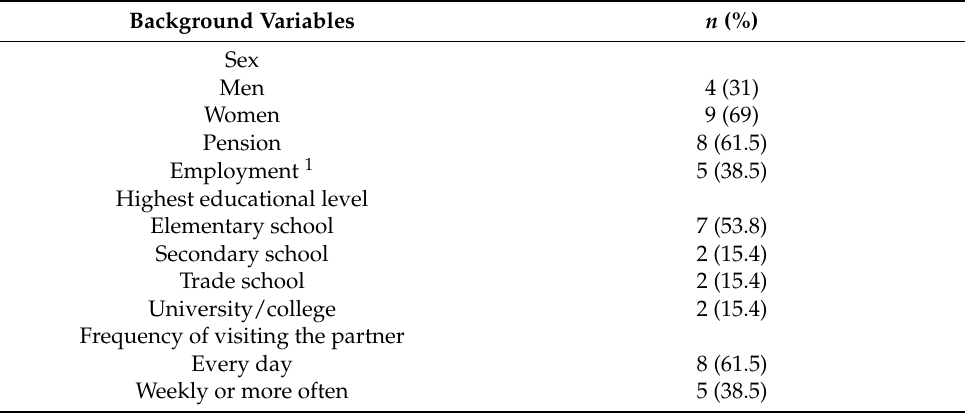
Table 1. Characteristics of the interviewed spouses ( n =